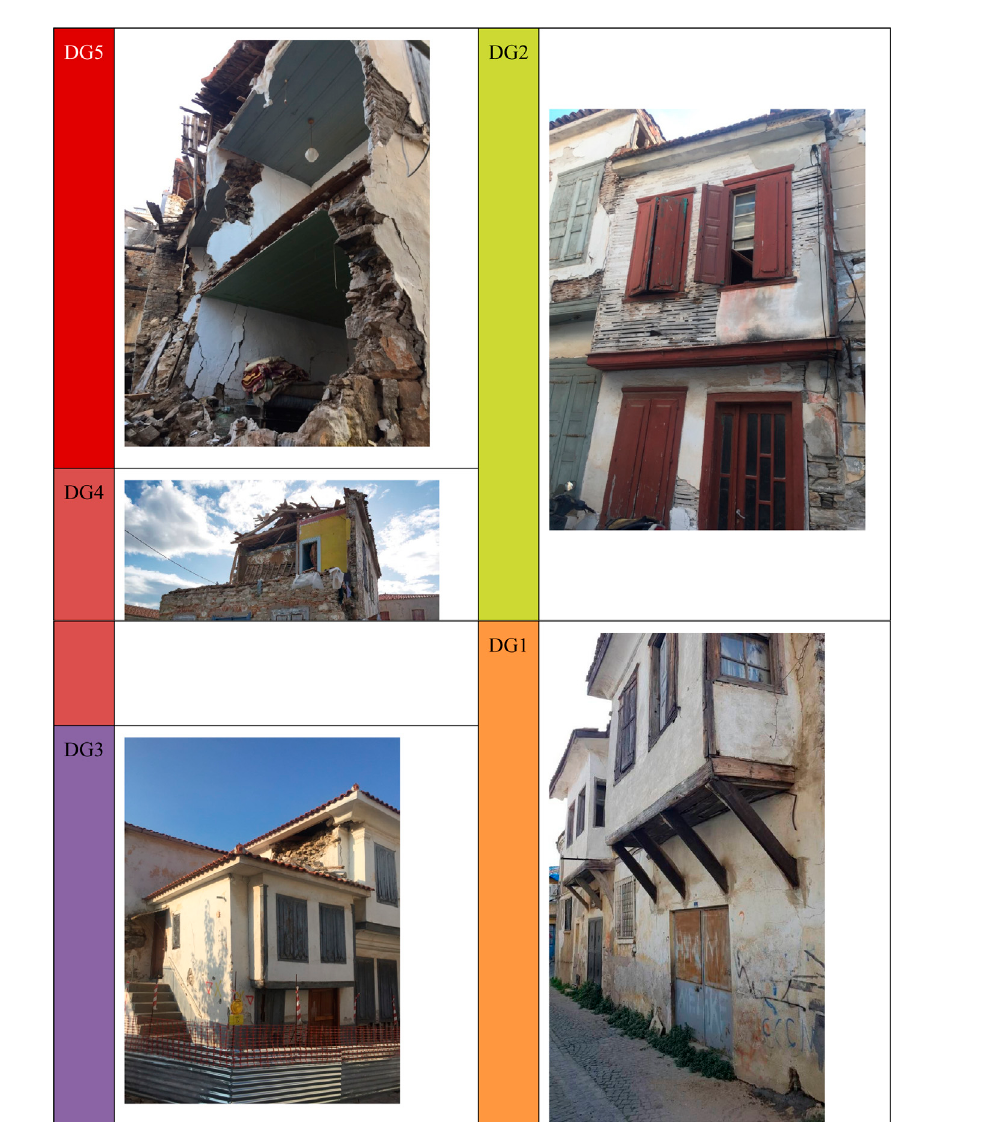
TABLE 5 | Examples of timber-masonry structures at different damage classes (DG1 in Ku ş adas ı , DG2-5 in Samos).